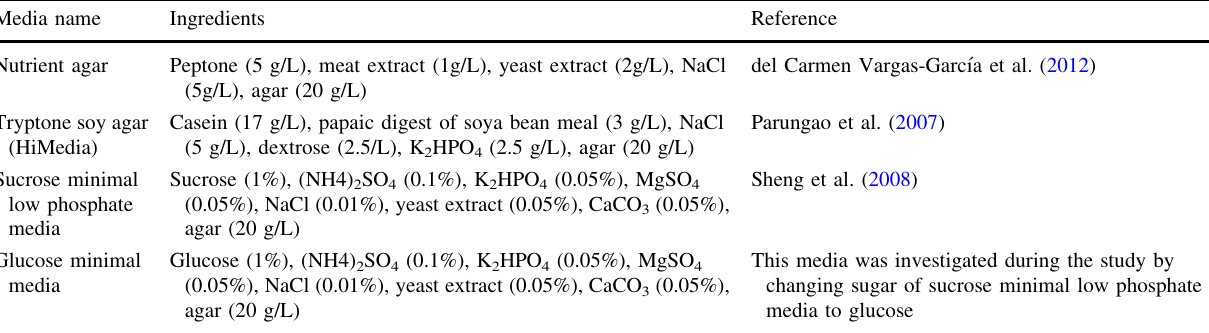
Table 1 Media compositions and their literature